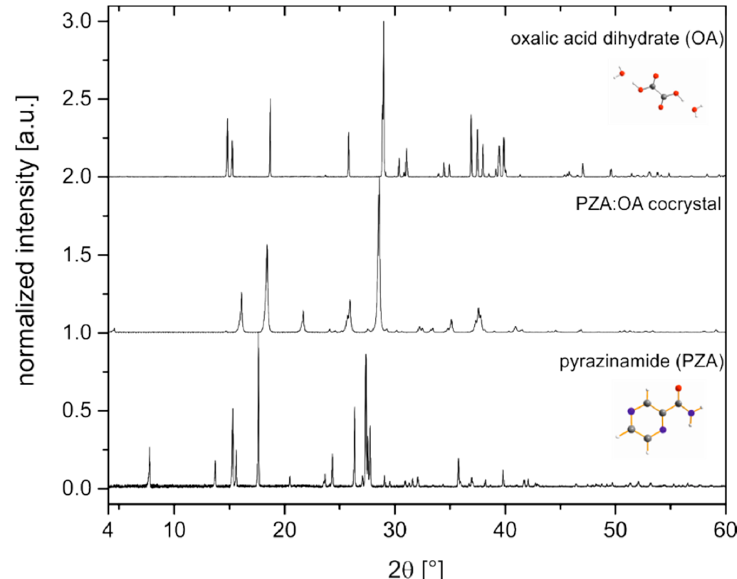
Figure 1. Powder patterns of the PZA:OA (1:1) cocrystal ( center ) and the reactants pyrazinamide ( bottom ) and oxalic acid dihydrate ( top ).